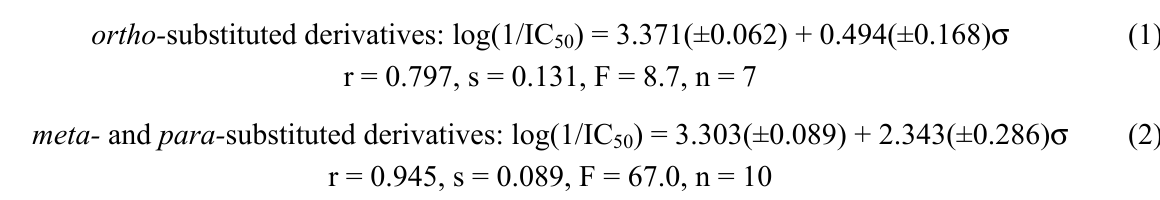
) [mol/L] in spinach 50